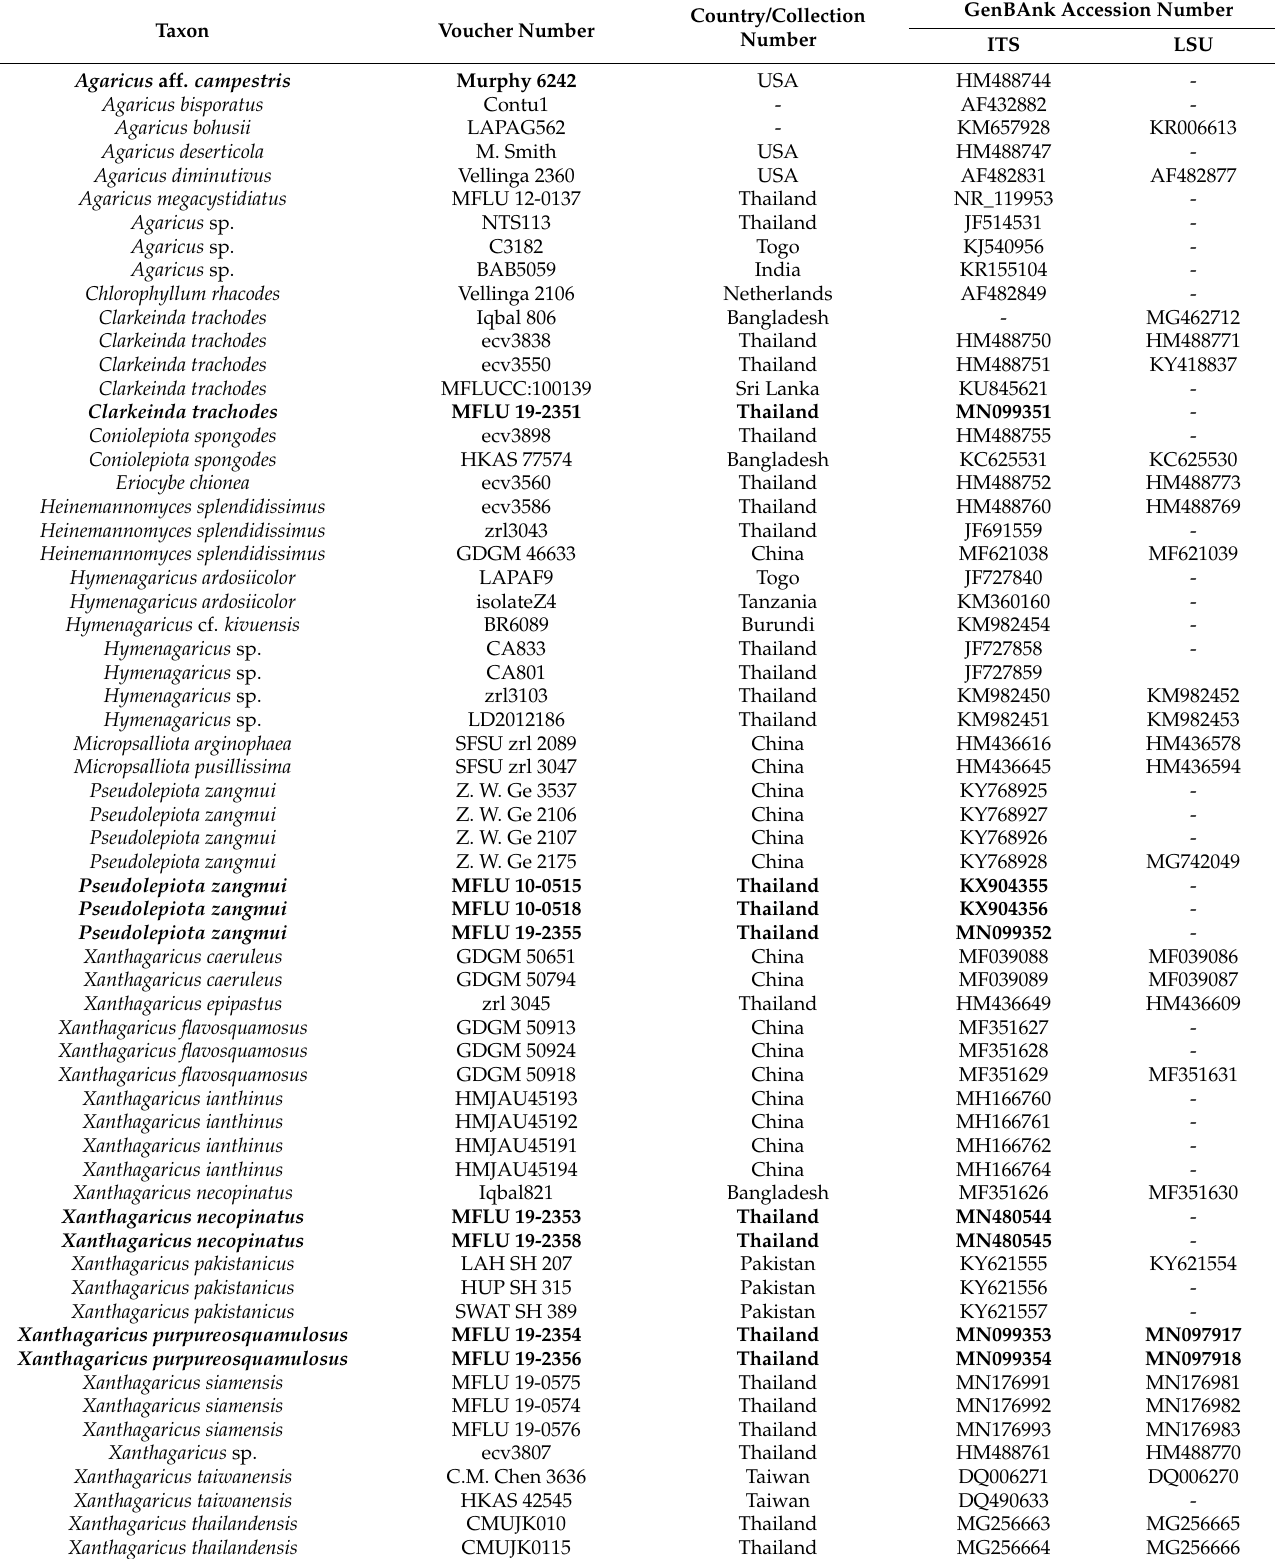
Table 1. List of collections of taxa in the Agaricaceae and their GenBank accession numbers used in the molecular analyses of dataset